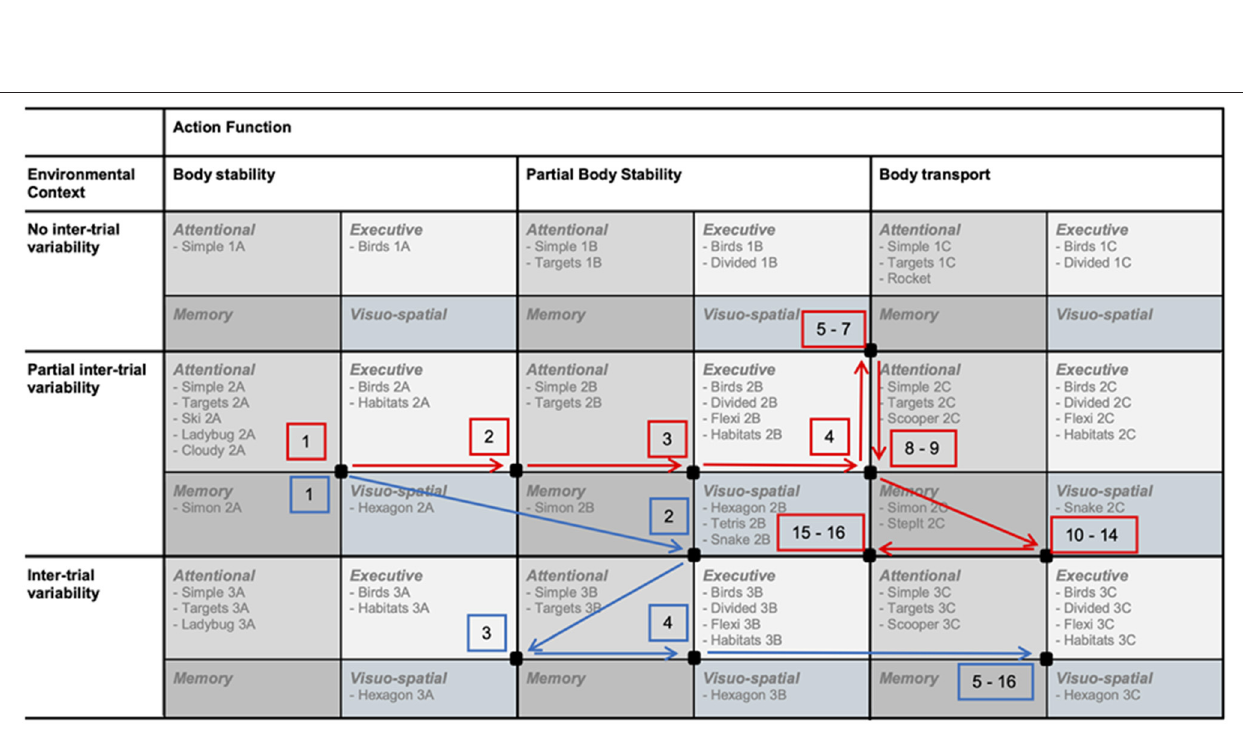
Frontiers in Aging Neuroscience |